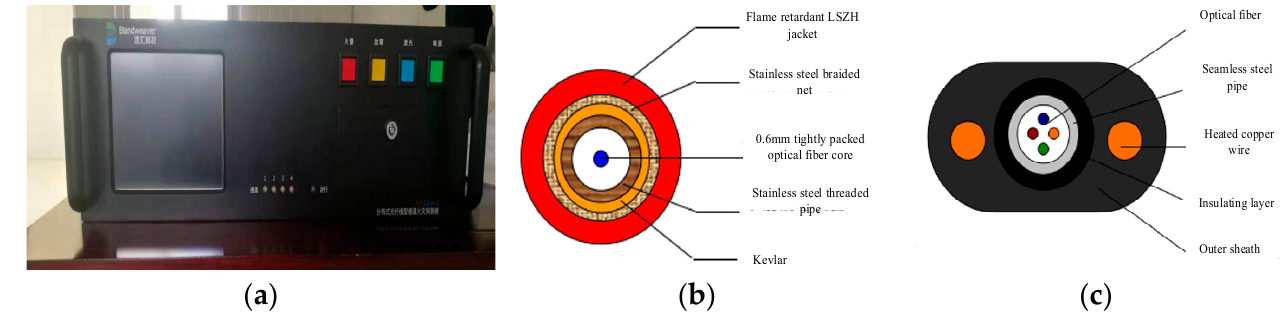
Figure 3. Optical fiber temperature measurement system; ( a ) DTS demolition instrument; ( b ) Ar- mored temperature measuring optical cable; ( c ) Heating armored temperature measuring optical cable.